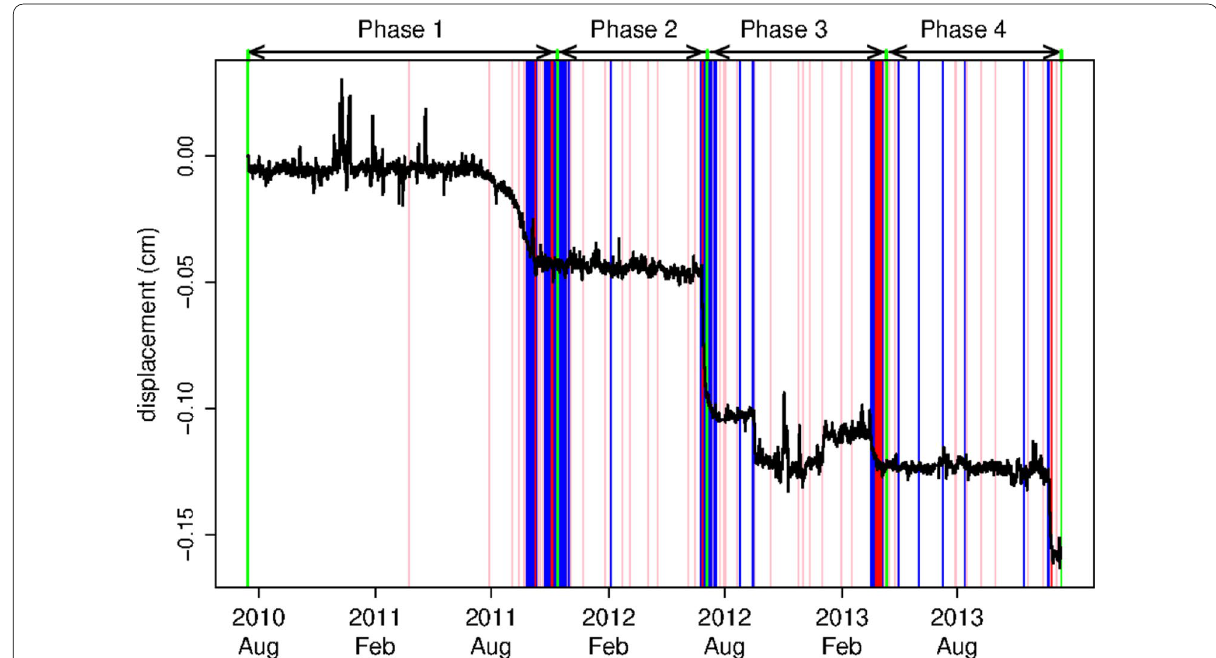
Fig. 4 Displacement data series in the four analysed phases. The earthquakes bigger than 4 magnitude are in red, the earthquakes bigger than 3 magnitude are in blue and the ones bigger than 2.5 are shown in pink